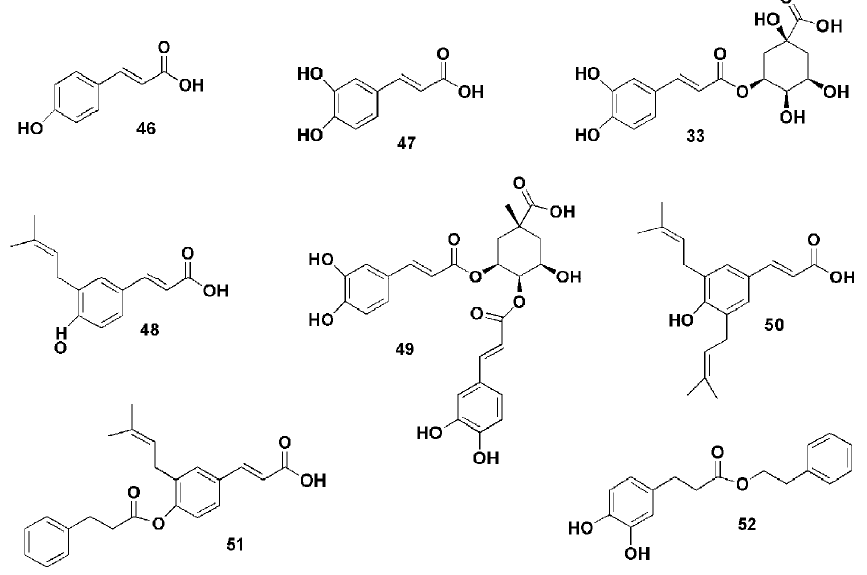
Figure 12. Chemical structures of the cinnamic acid derivatives in propolis components [41].